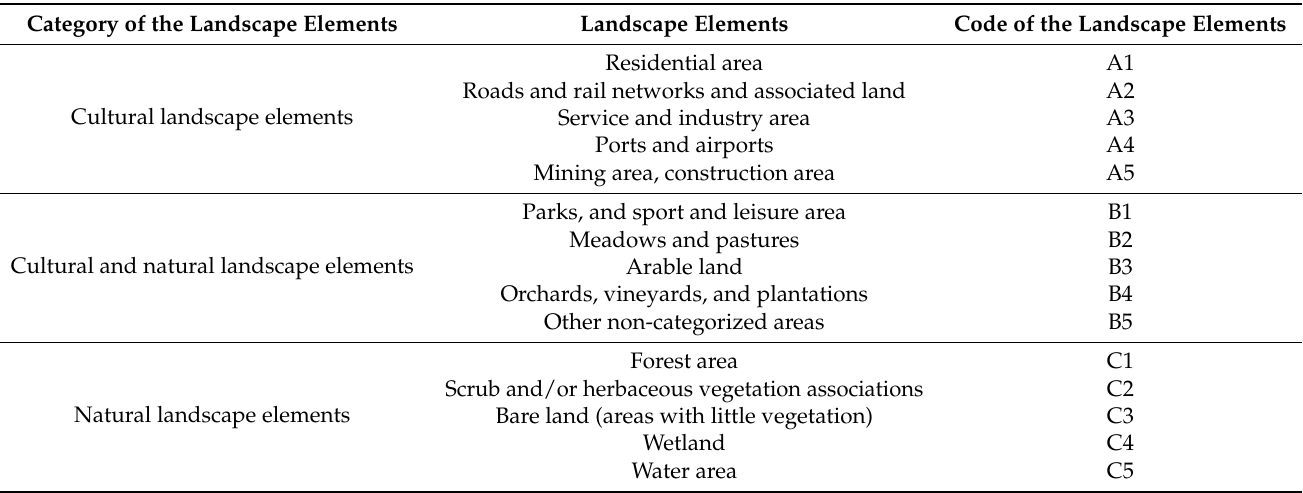
Table 1. Classification of land cover